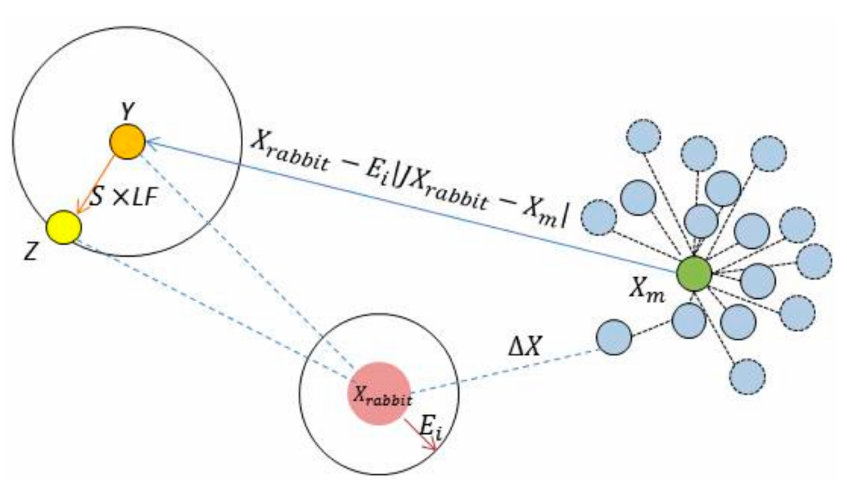
Figure 4 is the sketch map of the process of IHHO.